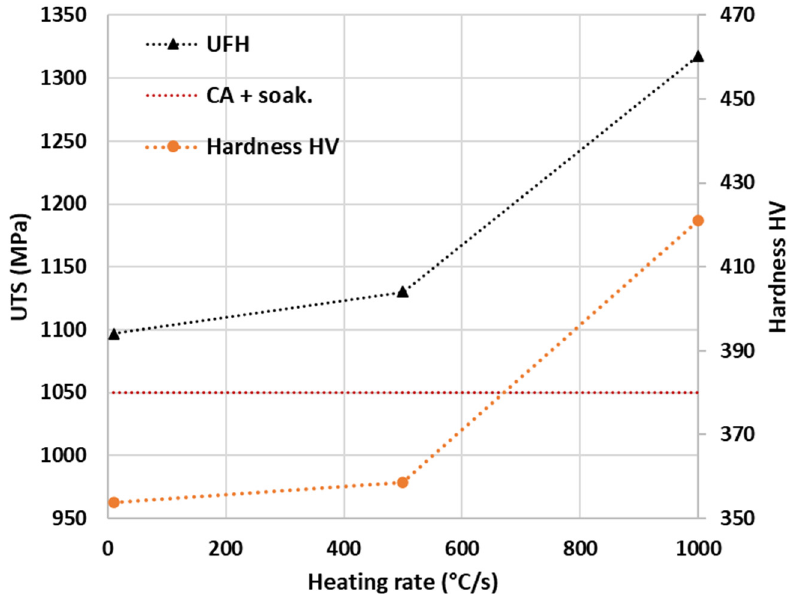
Figure 8. Effect of HR increase on UTS and Vicker hardness value of a low/medium carbon steel undergone the UFH process compared to CA + soaking process (steel chemical composition 0.25%C + 1.5%Si + 3.0%Mn)). Peak temperature of 850 °C, and cooling rate of 20 °C/s (data from [40]). A comparison of CA (5 °C/s) and UFH (500 °C/s) on dual-phase steel [39] showed the following results: the UTS improved from 625.0 ± 3.6 MPa to 666.0 ± 2.6 MPa (~6.5%), the YS increased from 277.0 ± 8.1 MPa to 372.0 ± 3.0 MPa (~34%), and the uniform elongation